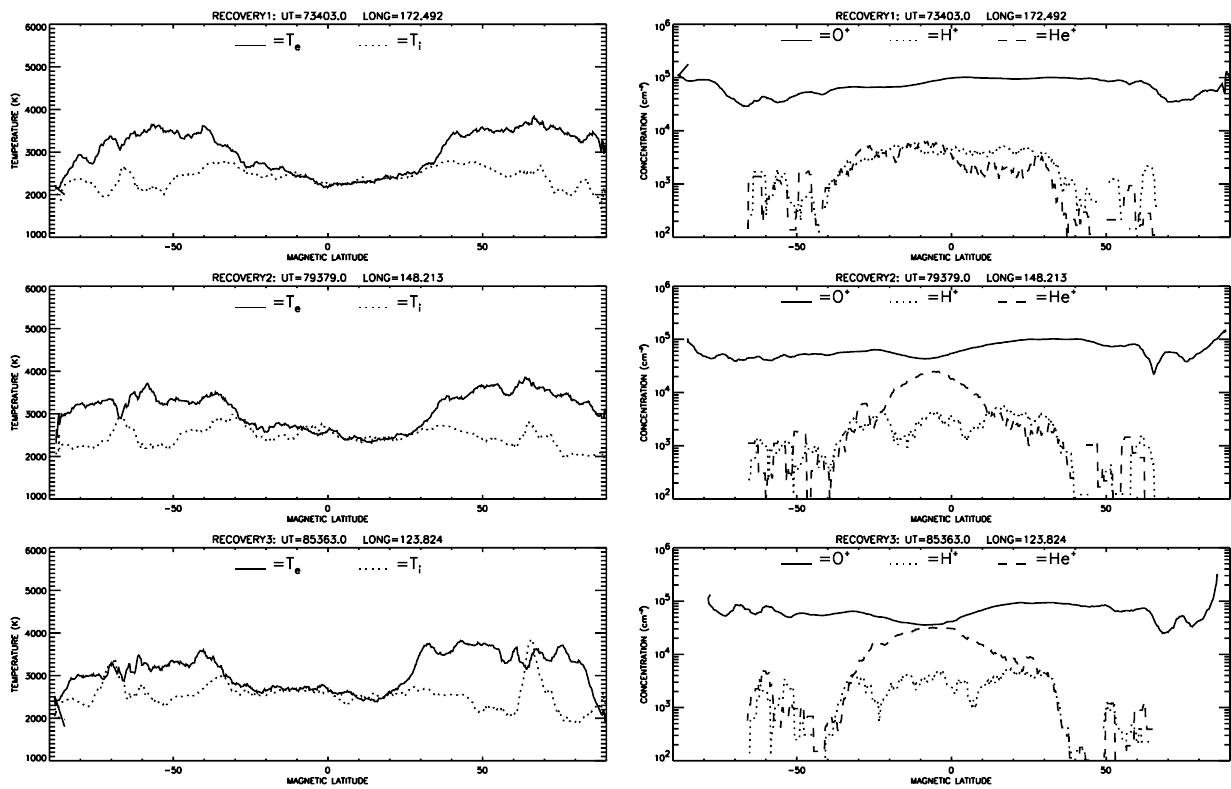
Fig. 3. As Fig. 2, except that the orbits are taken from 27 March, a day during the recovery